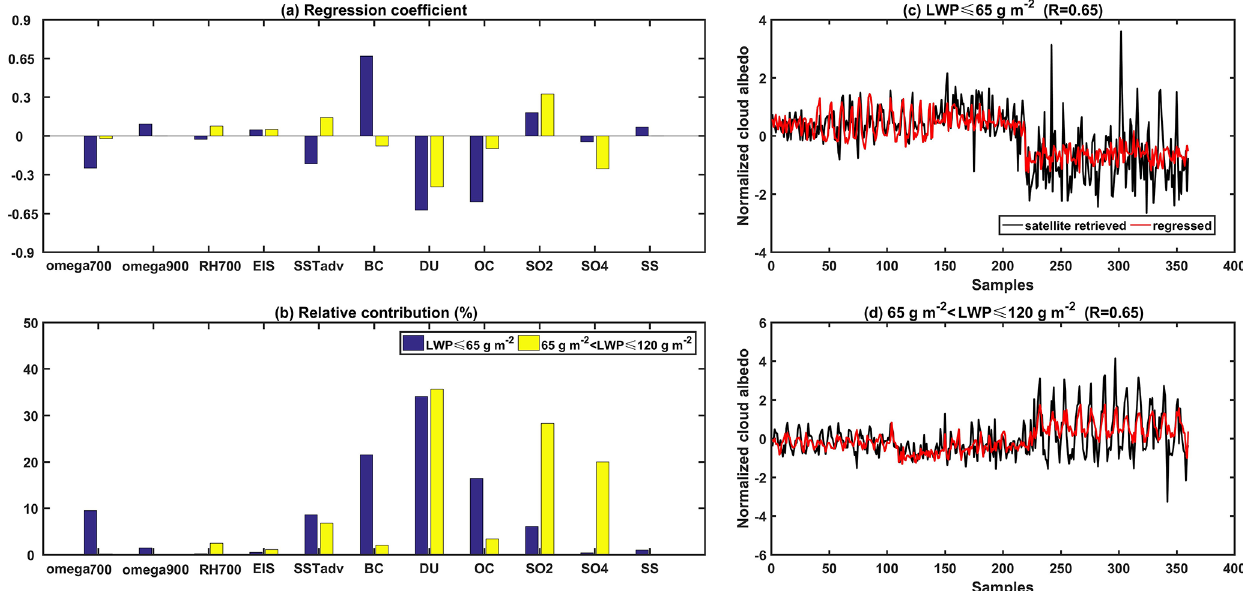
Figure 6. The (a) regression coefficients and corresponding (b) relative contribution of each predictor variable related to cloud albedo from the multilinear regression models under two LWP conditions: LWP ≤ 65gm − 2 (blue) and 65gm − 2 < LWP ≤ 120gm − 2 (yellow). Note that for ease of comparison, 11 variables are given in the figure, and variables without values are not predictive variables of the sample group. The satellite- and model-driven normalized cloud albedo trained in two sample groups: (c) LWP ≤ 65gm − 2 and (d) 65gm − 2 < LWP ≤ 120gm − 2 . The correlations ( R value) between satellite- and model-driven normalized cloud albedo are given in